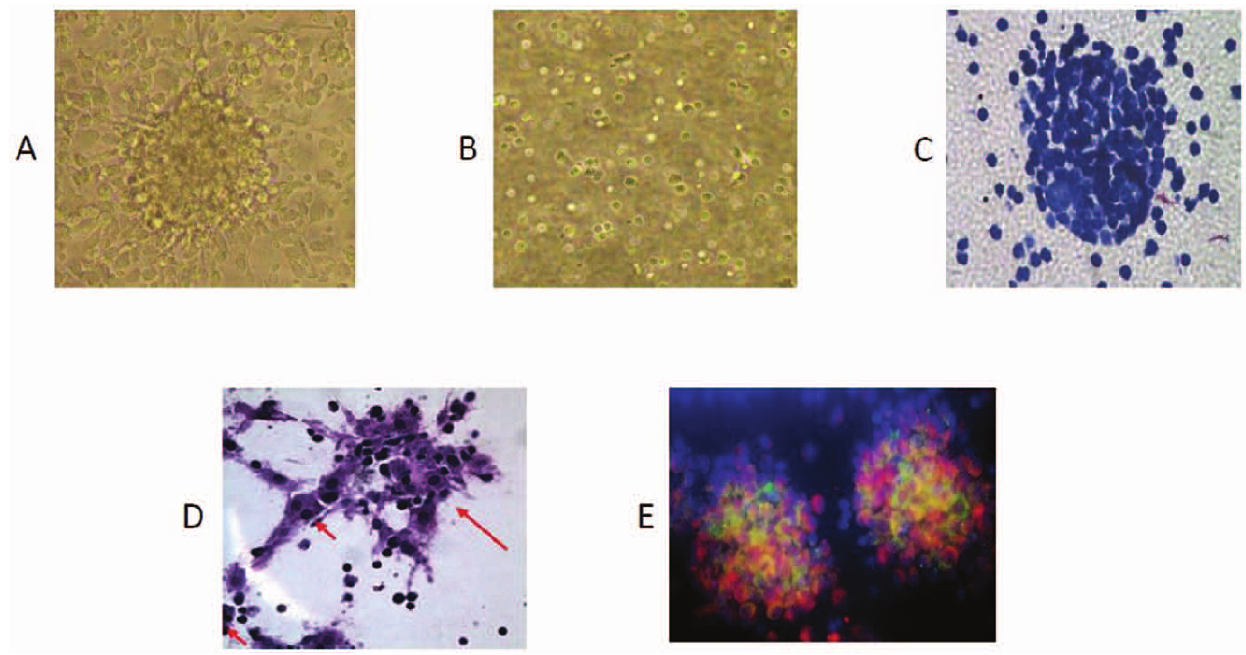
Figure 1. Infection of human PBMC with Mycobacteriumtuberculosis resulted in the formation of microscopic granulomas. ( A ) Infected PBMCs, ( B ) uninfected PBMCs, ( C ) H & E staining showing micro granulomas, ( D ) H & E staining showing multinucleated giant cells. ( E ) Fluorescent staining of granulomas sections with DAPI (nuclear stain), CD68 (macrophage marker-shown in red) and CD3 (T cells-shown in green) monoclonal antibodies.